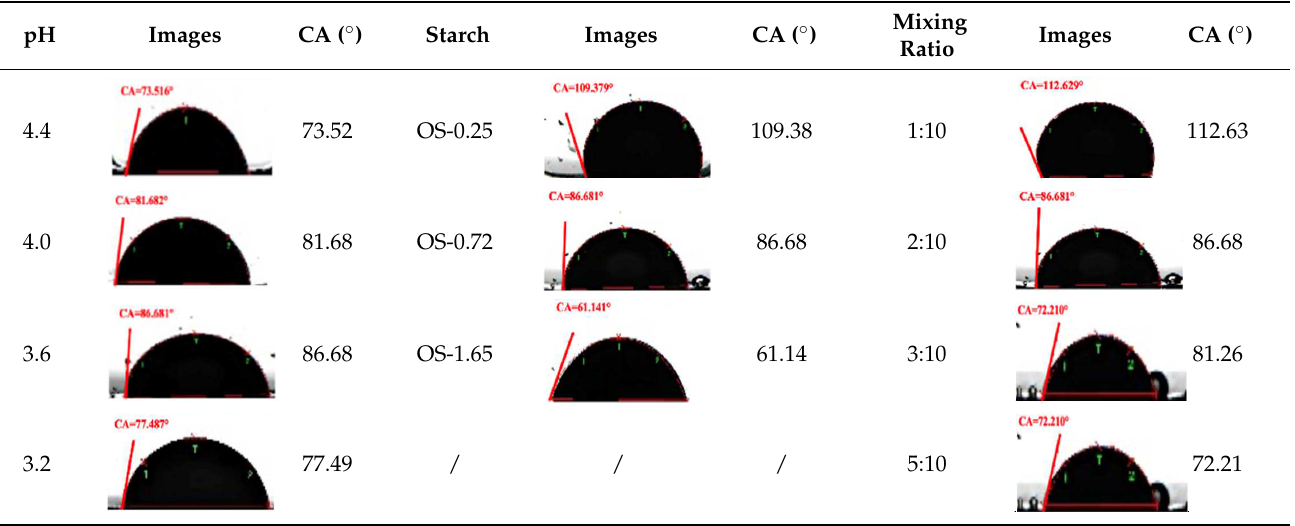
Table 2. Contact angle micrographs of OS/ β -lg complex coacervates obtained at different pHs, mixing ratios, and DSs of oxidized starch.